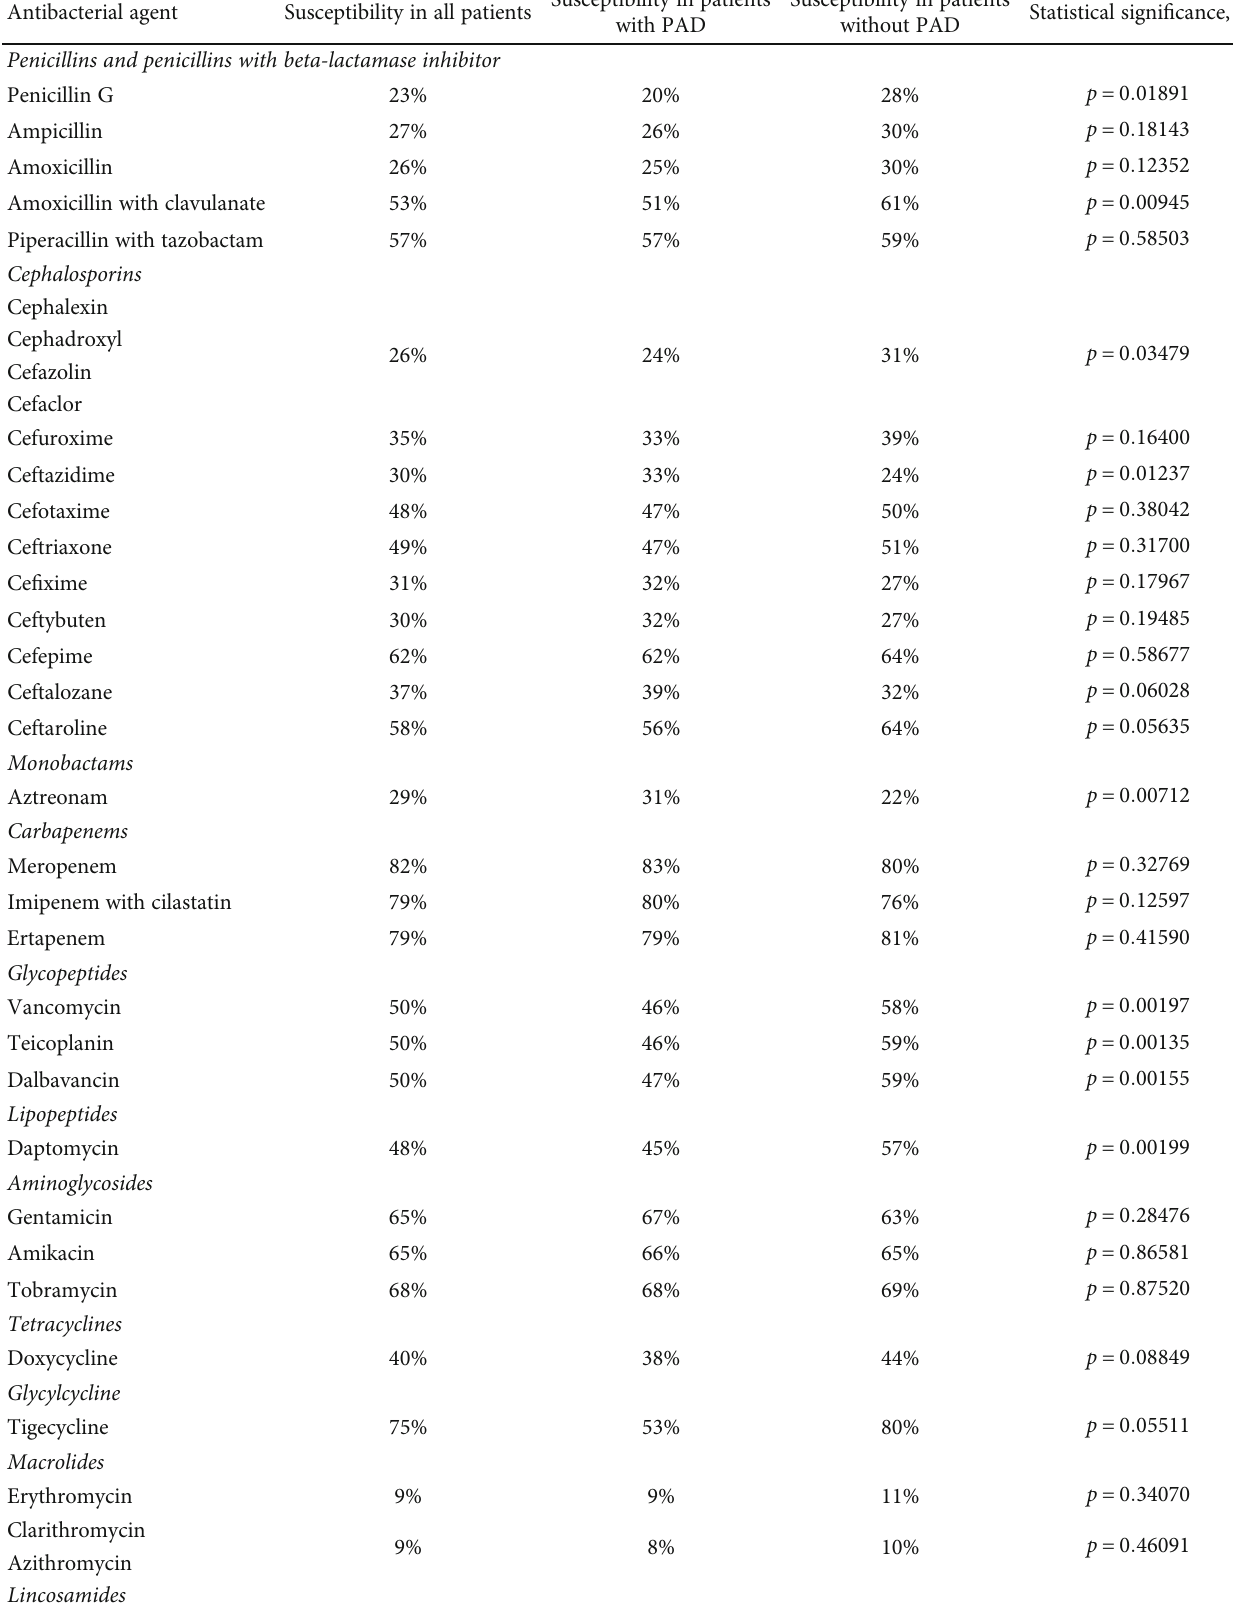
Table 5: Susceptibility of bacterial strains to antibiotics in the entire study group, in people with or without PAD (peripheral arterial disease). Antibacterial agent Susceptibility in all patients